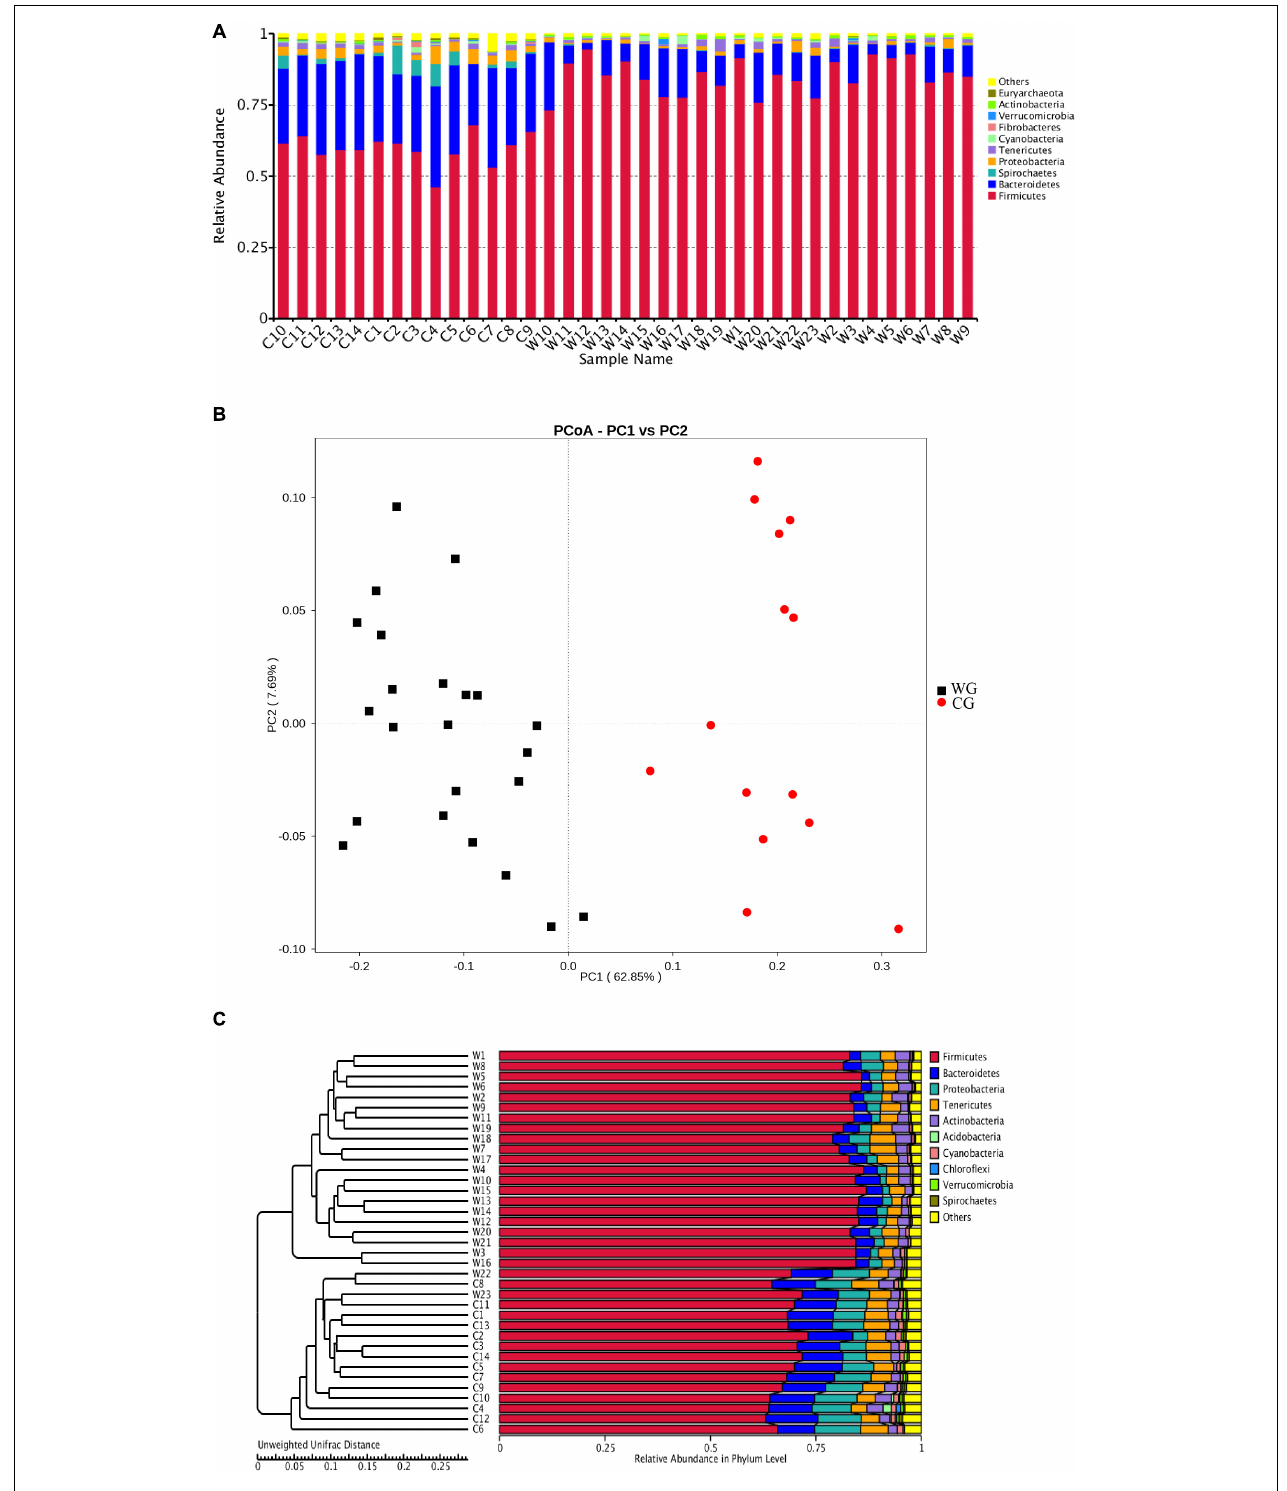
FIGURE 1 | Both the structure of flora and the unweighted UniFrac distance analysis reveal hierarchical separation of two musk deer groups. (A) Bacterial OTUs from 37 musk deer gut communities classified to the phylum level. Bars for each library represent the percentage of species assigned to each phylum with 80% bootstrap confidence. (B) Weighted UniFrac PCoA, which shows structural segregation between the WG and CG cohorts (C for CG, W for WG). Symbols representing individual communities are colored (black: WG, red: CG). (C) UPGMA tree based on the Unweighted UniFrac distance method. The tree on the left side shows the distance of each sample; the graph on the right side shows the relative abundance of the species at the phylum level.